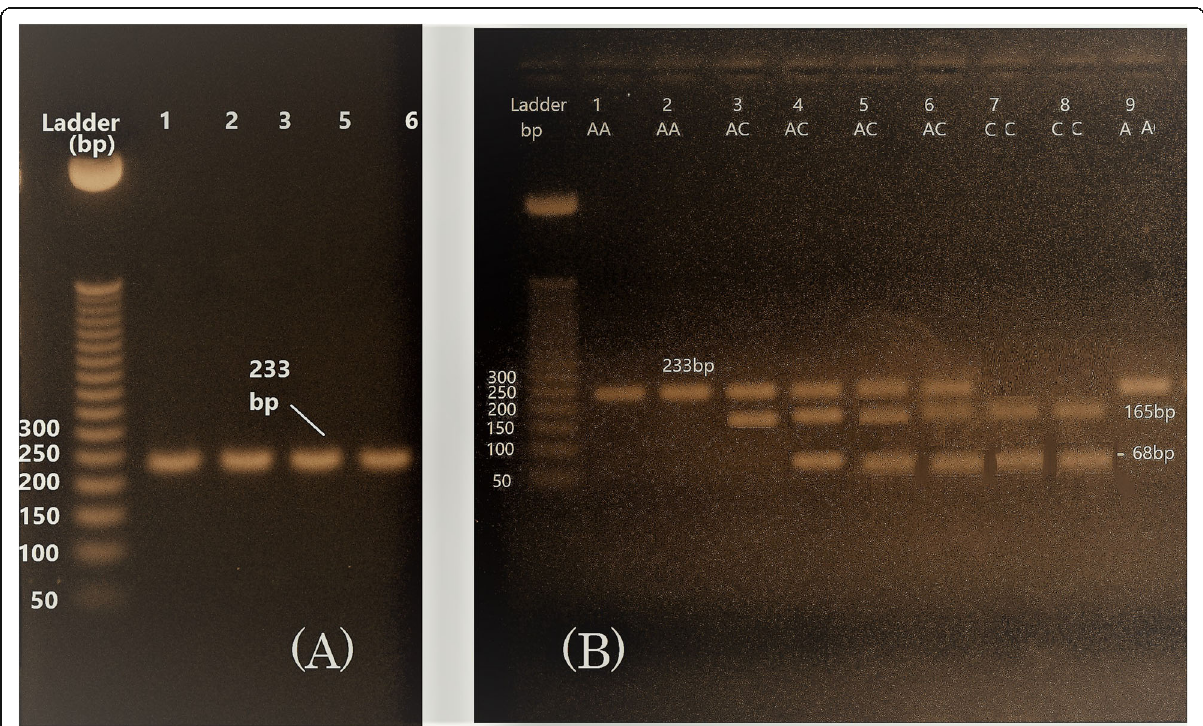
Fig. 1 Results of agarose electrophoresis of the interleukin (IL)-12B rs3212227 polymorphism. a Represent the PCR amplified product at 233 bp. b Represent the restriction fragment length polymorphism analysis reaction (RFLP). Lanes 3, 4, 5, and 6 represent the interleukin (IL)-12 AC genotype (three bands at 233, 165, and 68 bp). Lanes 7 and 8 represent the IL-12 CC genotype (two bands at 165 and 68 bp). Lanes 1 and 2 represent the IL-12 AA genotype (one band at 233 bp). The ladder is a 50-bp molecular-weight marker